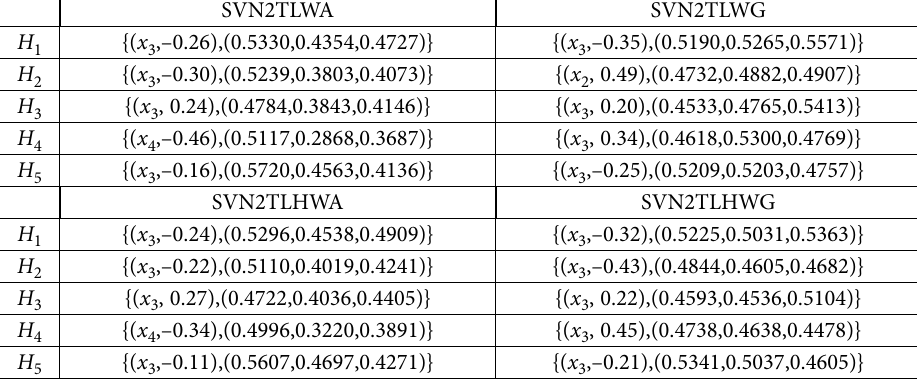
Table 7. The fused values by using some existing operator